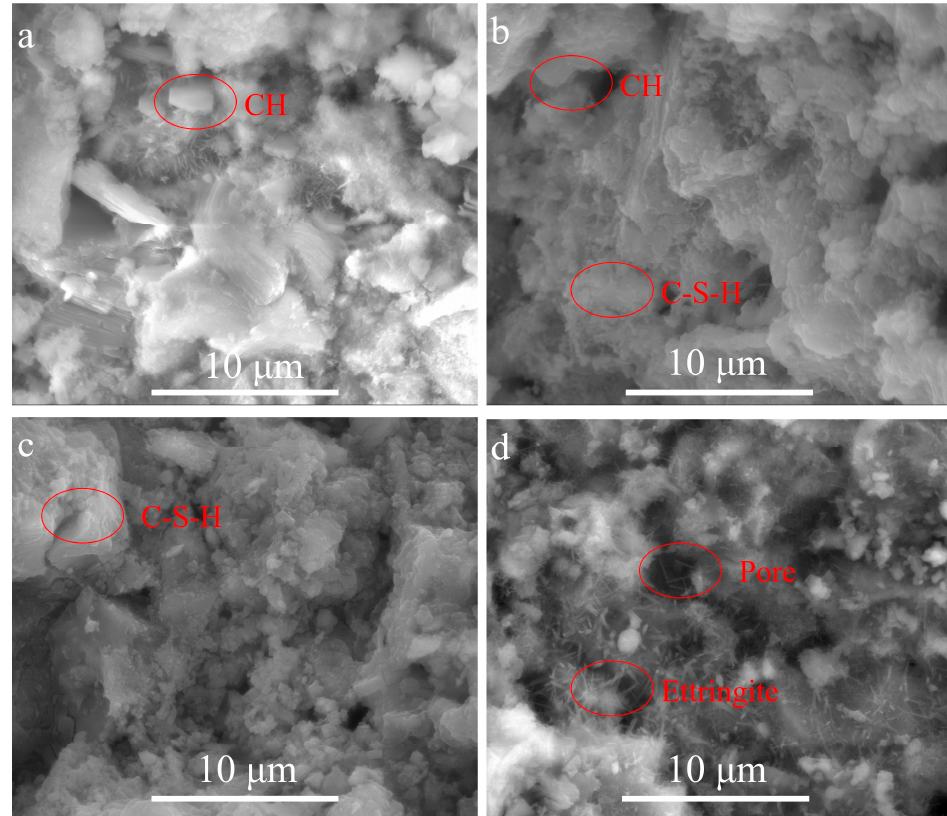
Figure 7. ESEM map of 28 d of age. ( a ) Cement; ( b ) CA20-90; ( c ) CA30-90; ( d ) CA40-90. The XRD patterns of pure cement paste and CA40-90 mixed with 40% copper slag powder at 3 and 28 d of age are shown in Figure 8.